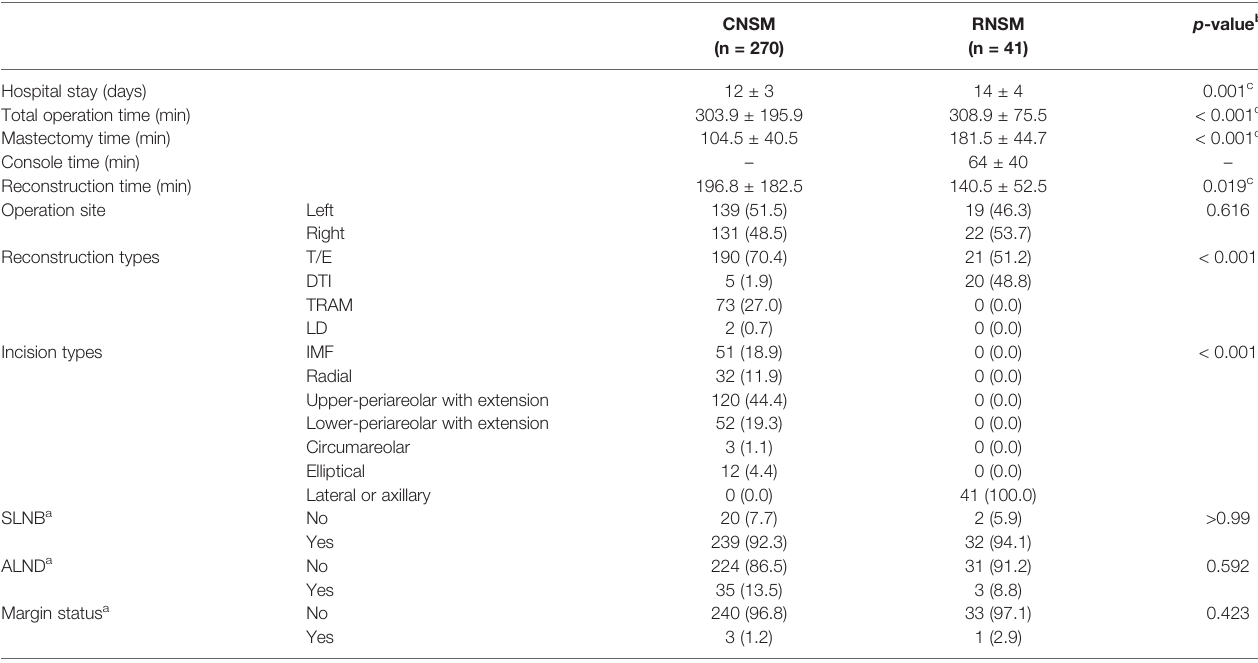
TABLE 2 | Surgical methods and post-operative